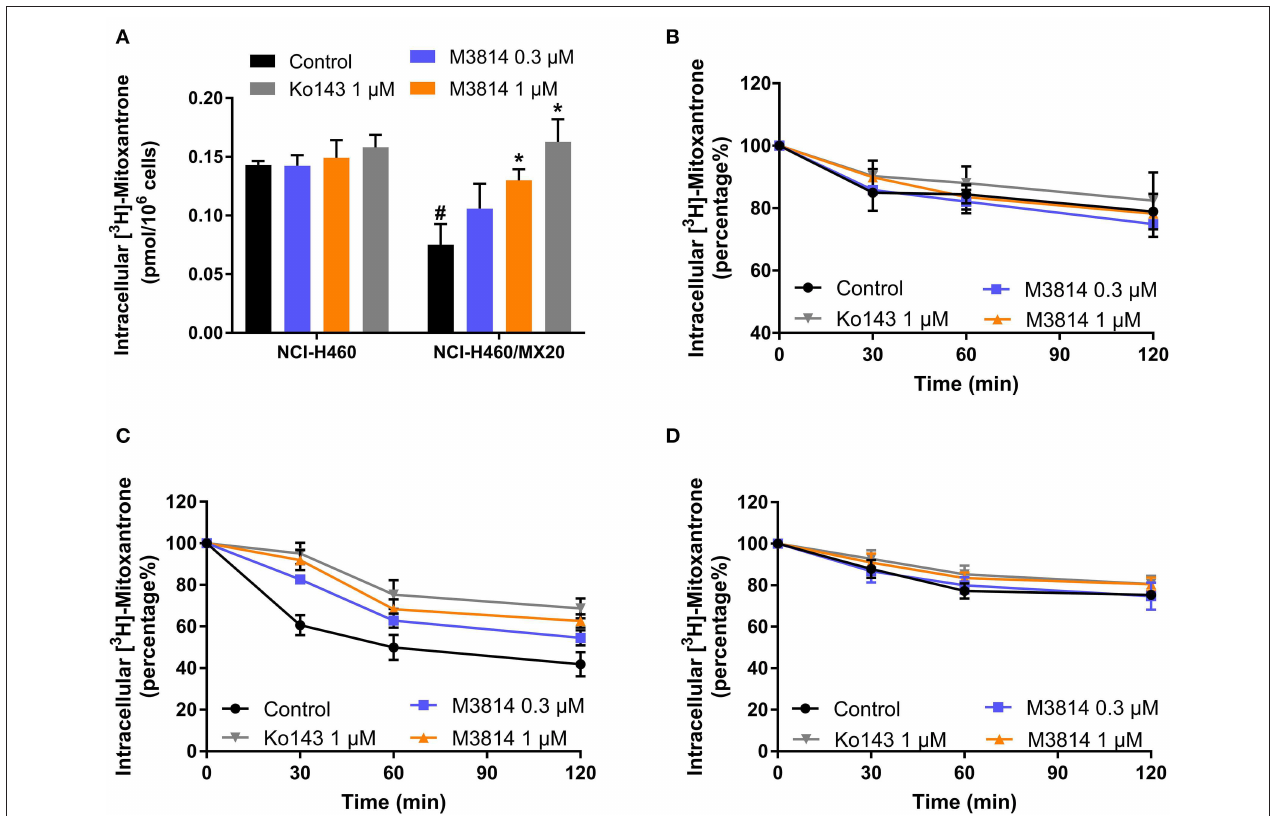
FIGURE 4 | Effect of M3814 on the accumulation and efflux of [ 3 H]-mitoxantrone. (A) The effect of M3814 on the accumulation of [ 3 H]-mitoxantrone in NCI-H460 and NCI-H460/MX20 cells. (B) The effect of M3814 on the efflux of [ 3 H]-mitoxantrone in NCI-H460 cells. (C) The effect of M3814 on the efflux of [ 3 H]-mitoxantrone in NCI-H460/MX20 cells. (D) The effect of M3814 on the efflux of [ 3 H]-mitoxantrone in NCI-H460/MX20 cells with 2,4-dinitrophenol pretreatment. Ko143 at 1 µ M was used as a positive control inhibitor of ABCG2. Data are expressed as mean ± SD from a representative of three independent experiments. * p < 0.05 vs. the control group, # p < 0.05 vs. the control group in parental cell